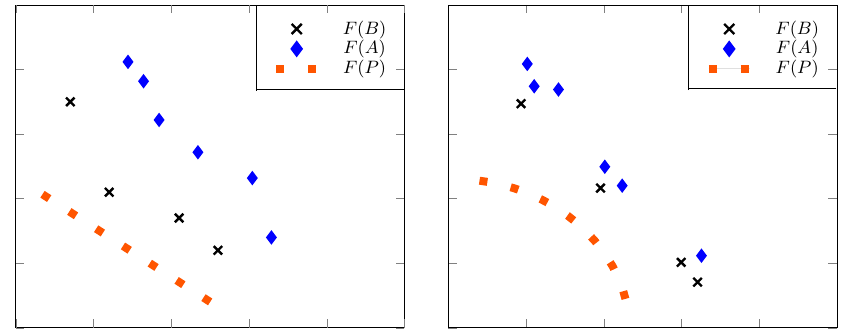
Figure 4. Two situations where IGD p , q ( B ) is better (smaller) than IGD p , q ( A ) for sufficiently negative q : Here, the hypotheses of Proposition 3 hold